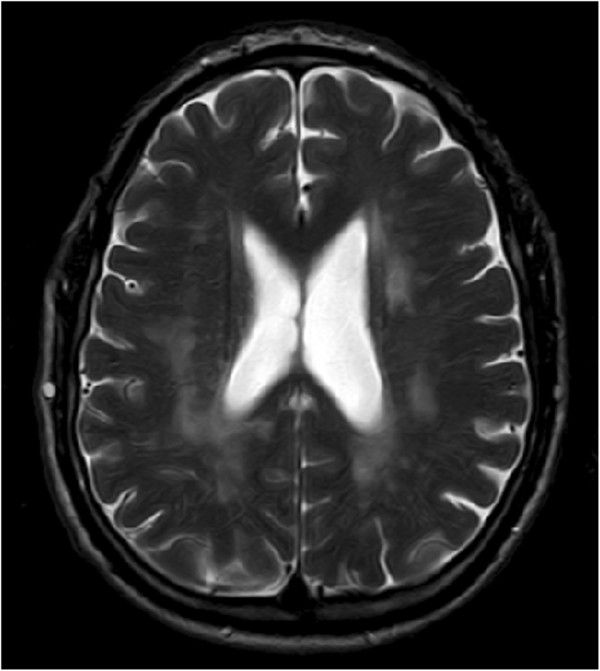
Central nervous system white matter lesions. 45-year-old male. T2 Brain MR image showed widespread, punctuated and confluent white matter lesions from periventricular to subcortical spaces. These lesions are associated with severe axonal injury (gliosis).